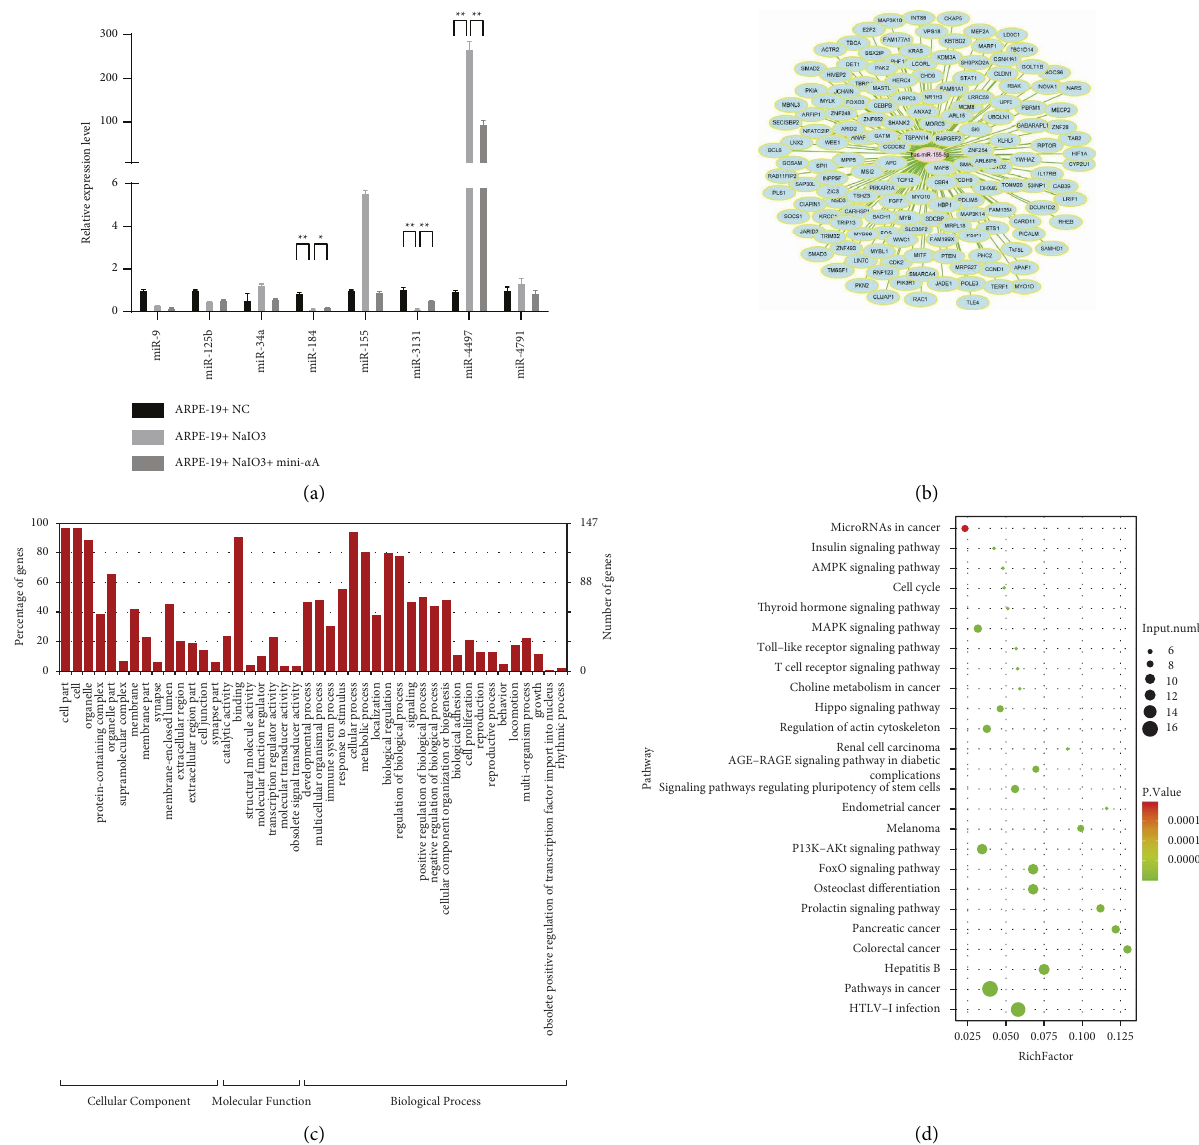
Figure 2: miRNA screening and enrichment analysis of target genes. (a) Eight miRNA (miR-9-5p, miR-125b-5p, miR-34a-5p, miR-184, miR-155-5p, miR-3131, miR-4497, and miR-4491) levels were determined using qRT-PCR. (b) Network map of miR-155-5p target genes. (c) GO analysis diagram of miR-155-5p target genes. (d) KEGG analysis of miR-155-5p target gene. ∗ P < 0 . 05 and ∗∗ P < 0 .